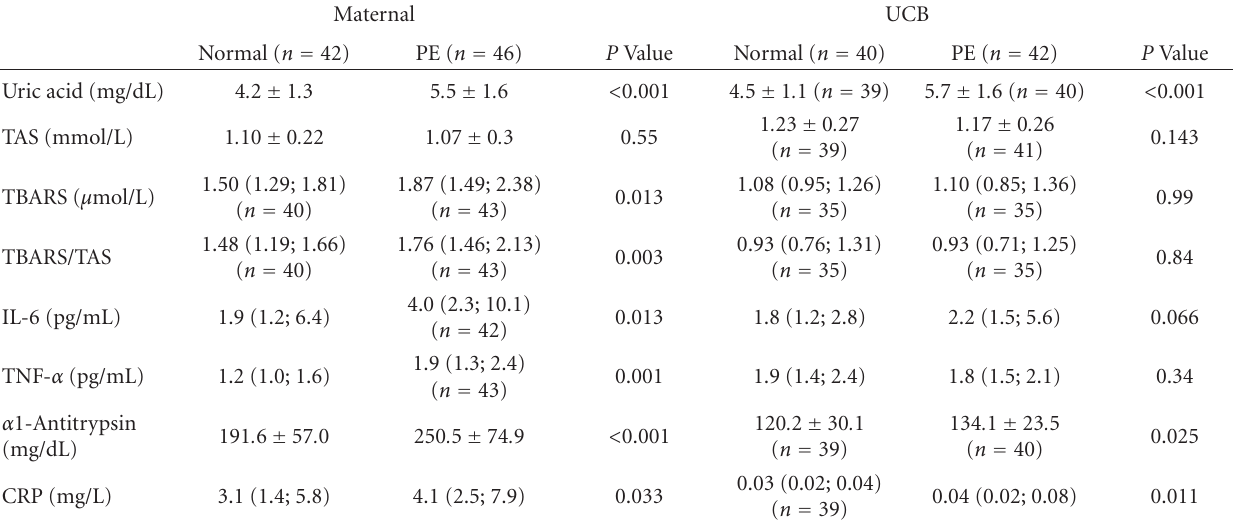
Table 2: Oxidative stress parameters, cytokines, and acute-phase proteins in maternal and cord blood, in normal and PE cases.